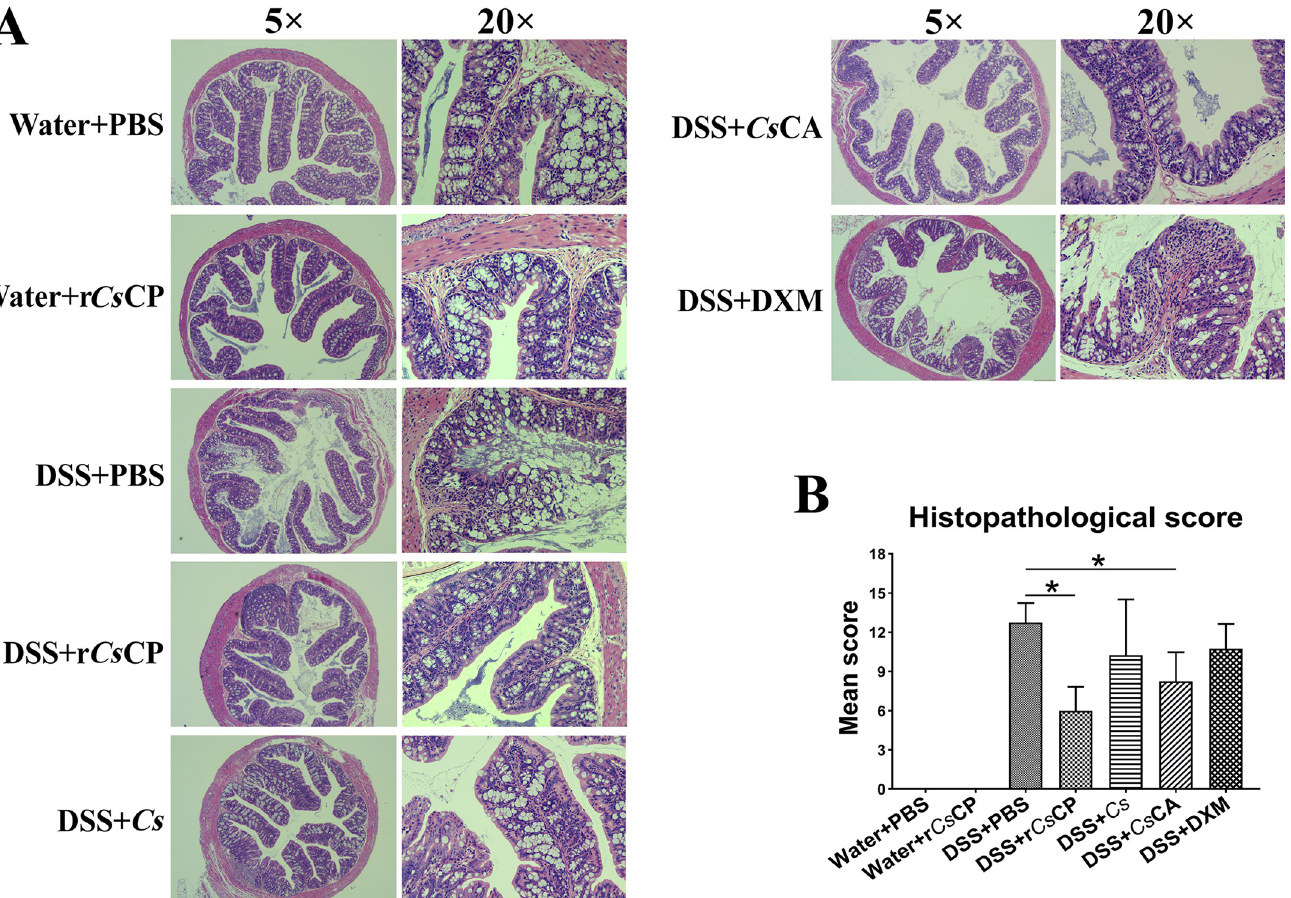
Fig 3. The histopathological changes of colon tissues in each group. On the 7th day of the experiment, the colon tissue of each group mice was isolated, and sections were prepared for H&E staining. (A) Representative colon histopathological sections of each group at objective 5 × and 20 × . (B) Histopathological scores of colon tissues (n = 4). Mean values ± SEMs are represented by bars. � P < 0.05.